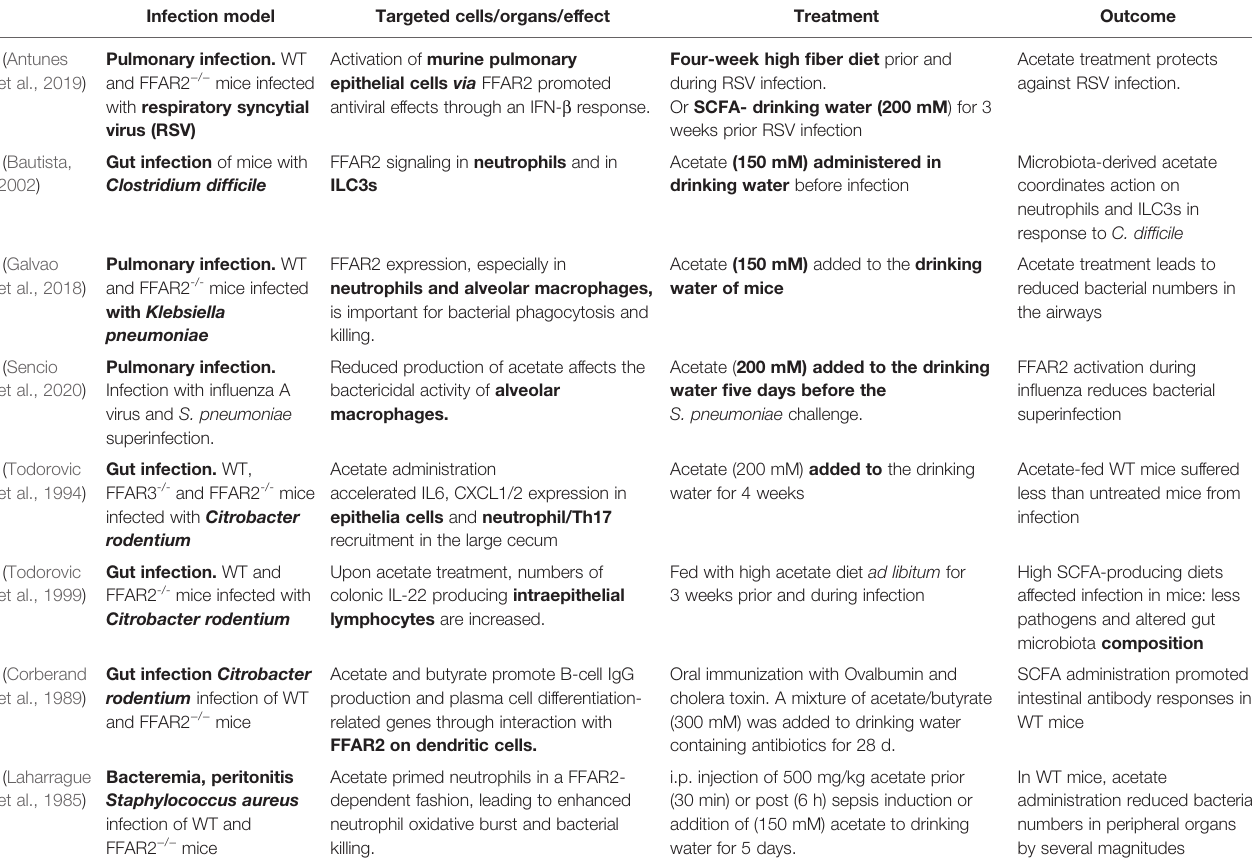
TABLE 1 | Consequences of the treatment of infectious diseases with the FFAR2 ligand acetate. Infection